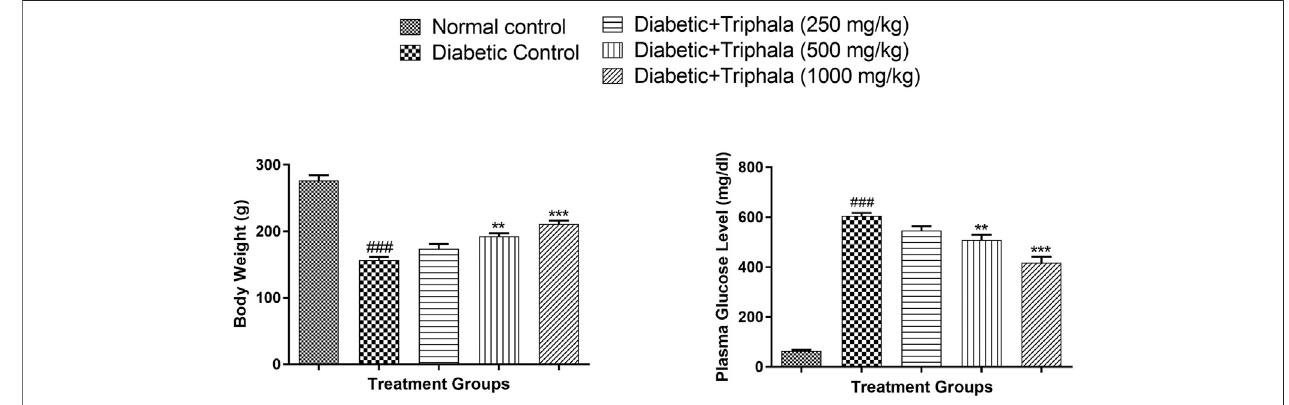
FIGURE 1 | Effect of Triphala churna on body weight and plasma glucose level. Data are expressed as mean ± S.E.M. ( n (cid:2) 6), ### p < 0.001 when compared to normal control, ** p < 0.001, *** p < 0.001 when compared to diabetic